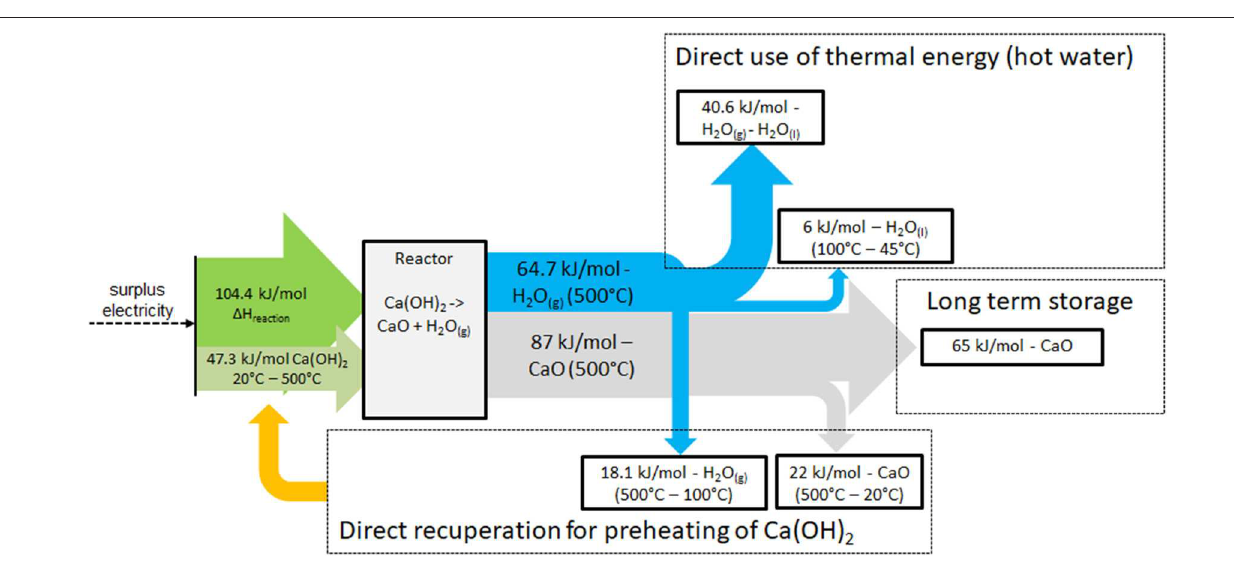
energy in 0.42 kWh directly usable thermal energy and 0.58